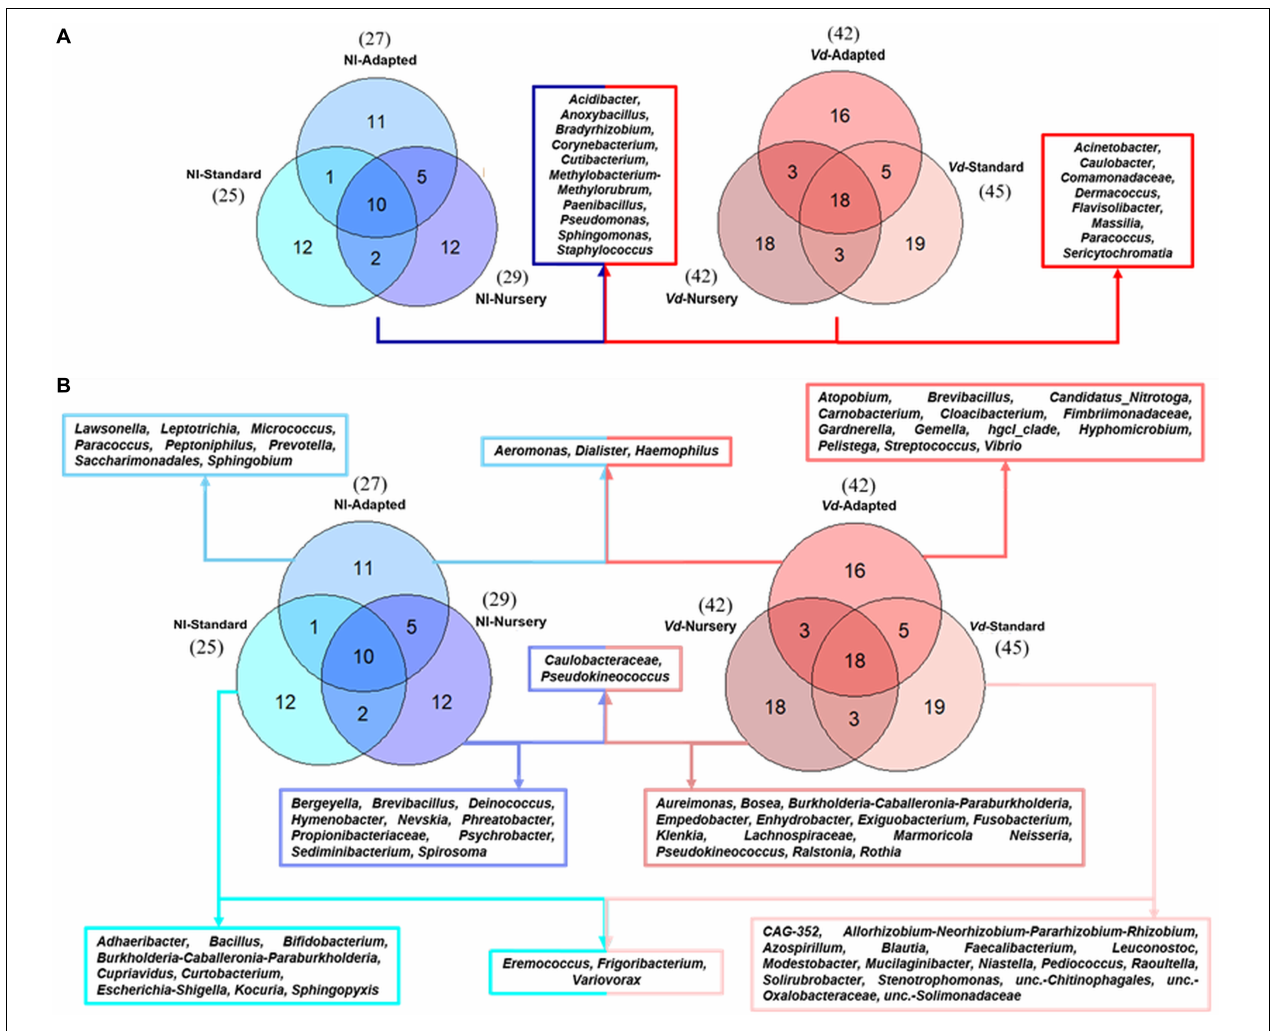
FIGURE 4 | Prevalence Venn diagram showing the unique and shared bacterial genera in olive xylem from the core microbiome (A) or by each propagation approach (B) obtained from Verticillium dahliae ( Vd )-inoculated and non-inoculated (NI) “Ac-18” plants following in vitro (standard and adapted) and nursery propagation